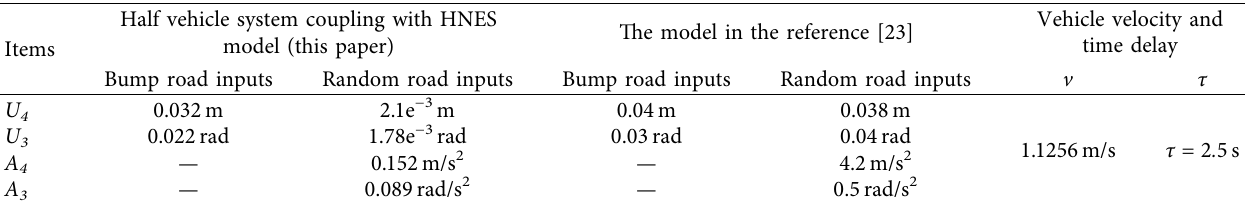
Table 3: Comparison of simulation